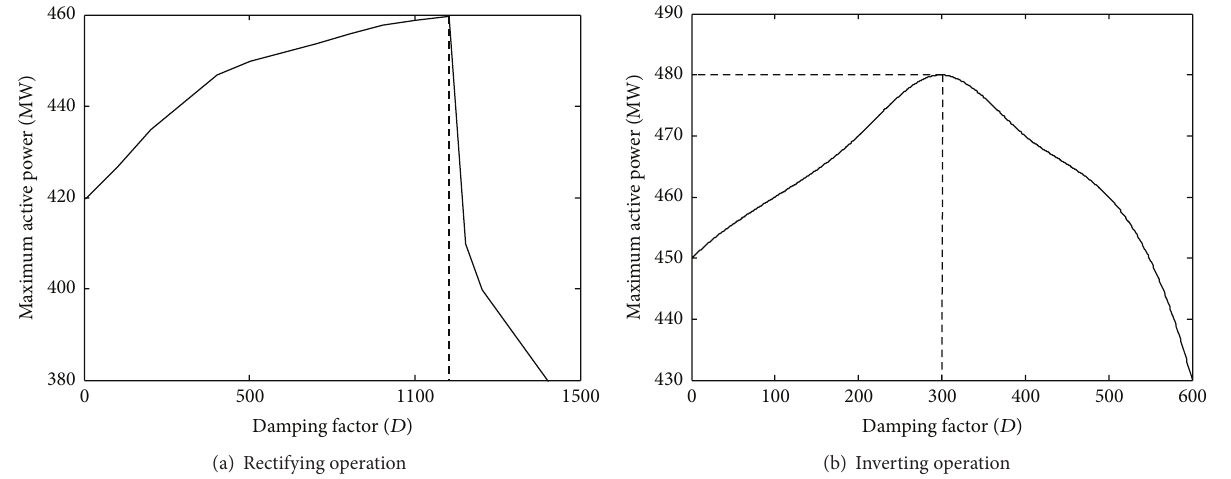
Figure 12: The relationship between 𝐷 and limits of power